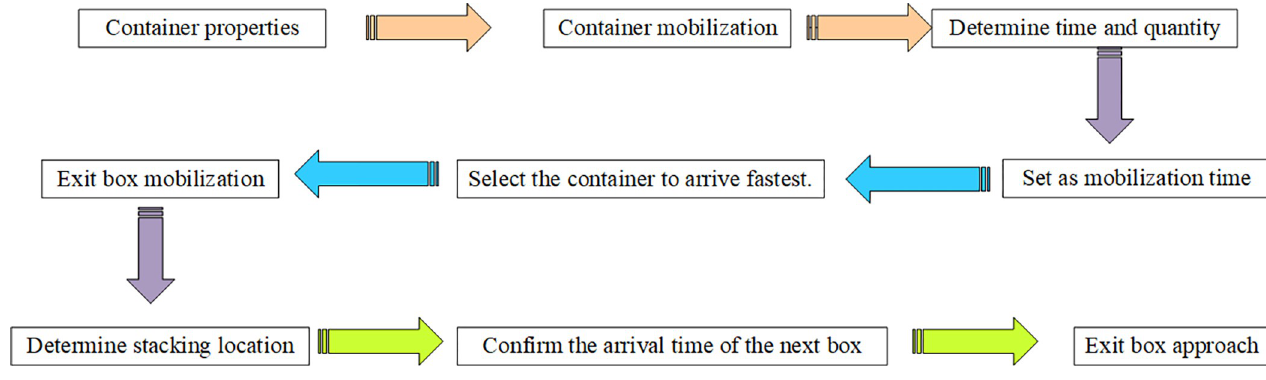
Fig 5. Outbound container mobilization.